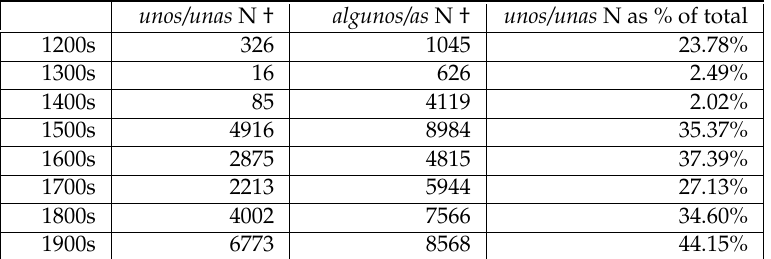
Table 5. Appearance of unos/unas N in CdE (raw